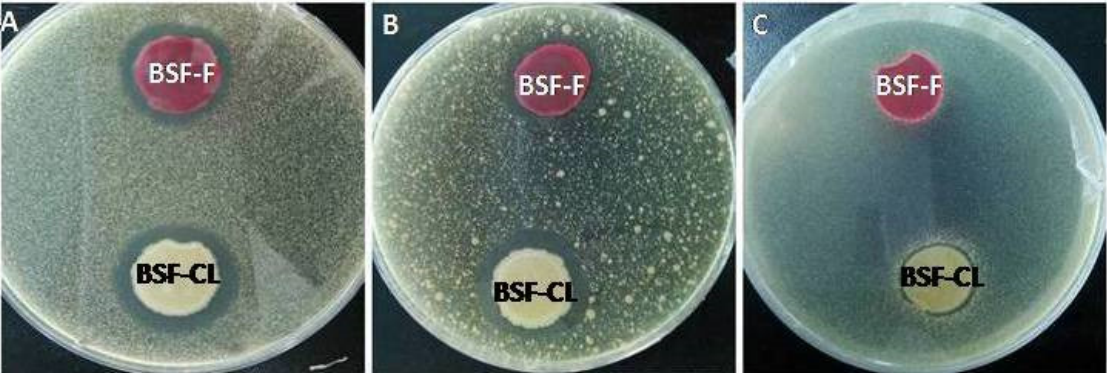
Figure 2. Bacteria from the guts of the BSF larvae inhibited the zoonotic pathogens in vitro. Strains BSF-CL and BSF-F inhibited ( A ) S. aureus and ( B ) E. coli ; Strain BSF-CL inhibited ( C ) Salmonella spp.